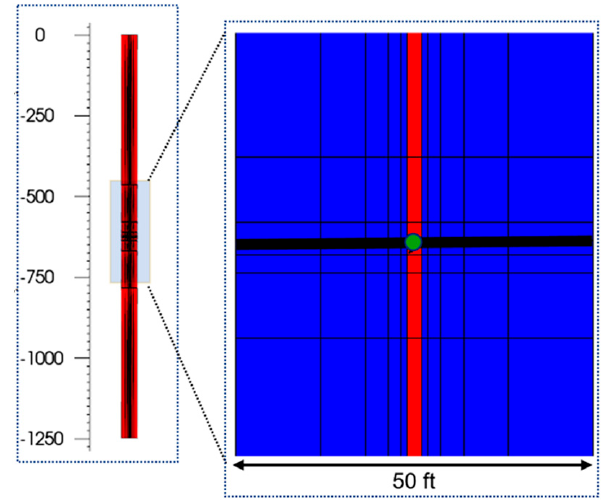
Figure 4. Symmetric fracture element used for simulation.